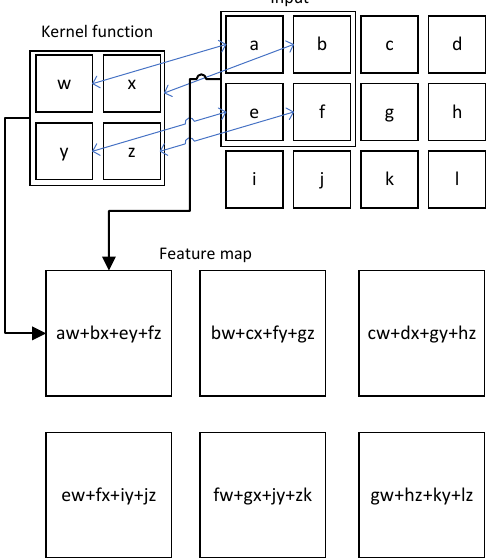
Figure 1. Two-dimensional convolution without kernel